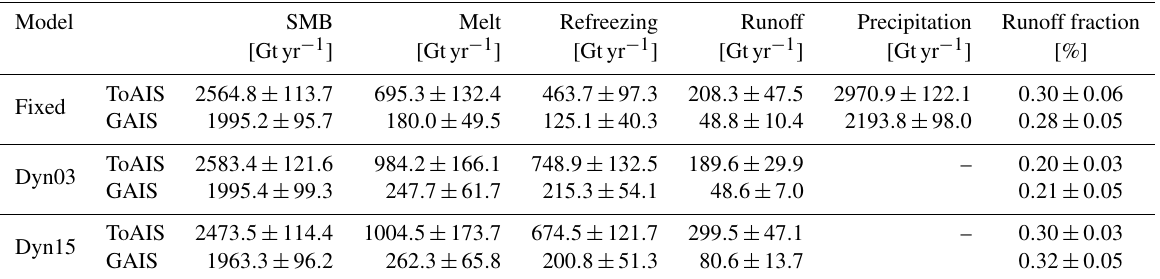
Table 2. Yearly mean SMB, melt, refreezing, runoff, precipitation, and runoff fraction (runoff over melt), ± with respective standard devia- tions, for both the total ice sheet (ToAIS) and the grounded ice sheet (GAIS). Note that all the model simulations are forced with the same precipitation. Model SMB Melt Refreezing Runoff Precipitation Runoff